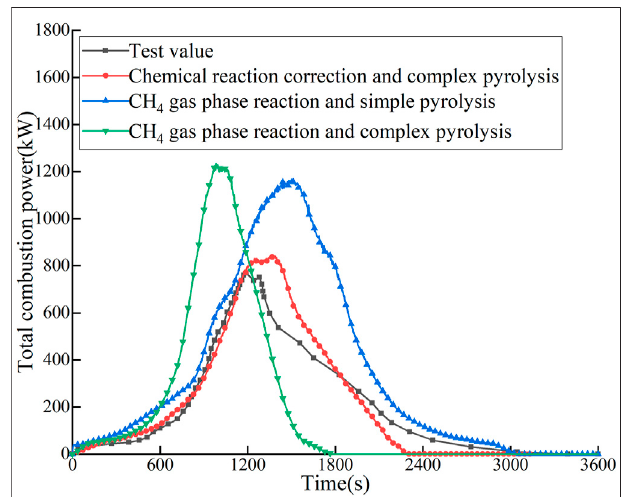
FIGURE1 | The comparison betweensimulation results and test data of total combustion